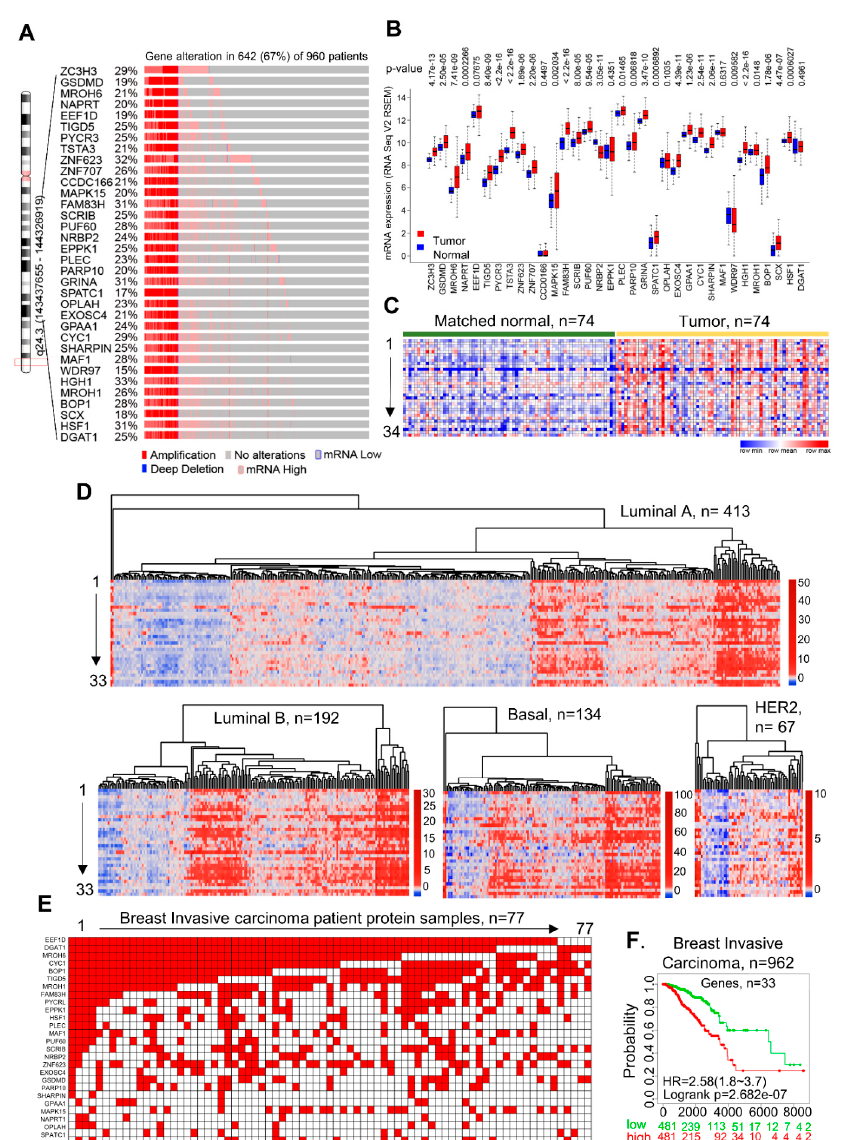
Figure 1. Overview of CanCord34 genes in breast cancer. ( A ) Dispersal of the genomic alterations in CanCord34 genes in breast cancer patients. Each row represents a gene, and each vertical line represents one patient sample. The alterations are defined with different colors and patterns. The data were taken from the cBioPortal platform. ( B ) Boxplot image showing differences between the expression patterns of CanCord34 genes in normal and matched tumor samples. The significance of the difference between the gene expression levels was evaluated using the Mann–Whitney–Wilcoxon test. ( C ) Expression of CanCord34 genes in normal and matched tumor samples. Except for CCDC166, all other genes were upregulated in the tumor samples compared to the normal samples. ( D ) Heatmap representation of the levels of the CanCord34 mRNAs using the heatmap algorithm of R for different subtypes. The samples with high expression, ~32% of the total samples, are clustered together. Many specimens belonging to the basal and luminal B (LumB) sub-types exhibited the upregulation of CanCord34 genes. ( E ) Heatmap representation of samples with genes upregulated at the protein level. Each row represents a gene, and the columns represent the tumor samples. Genes are sorted in descending order of gene expression in the tumor samples. ( F ) Kaplan–Meier survival plots of the CanCord34 genes. Out of 34 genes, 33 were taken to classify the samples, because one of the genes, the CCDC166, could not be mapped in the dataset. The survival plot for the CanCord34 genes was generated using the SurvExpress